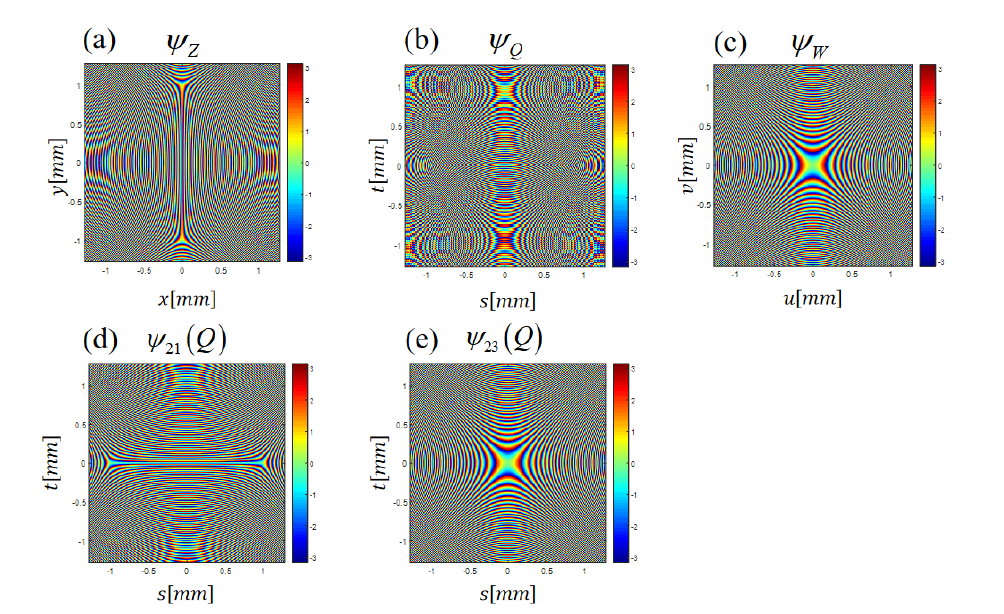
Figure 6. Phase distributions of three phase plates ψ Z ( a ), ψ Q ( b ) and ψ W ( c ), and the two phase functions ψ 21 ( Q ) ( d ) and ψ 23 ( Q ) ( e